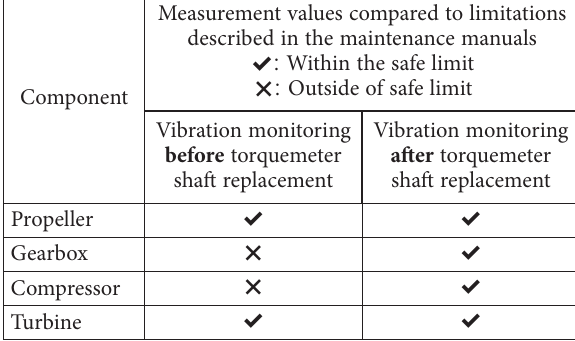
Table 1 . Vibration test measurement results Measurement values compared to limitations described in the maintenance manuals Component